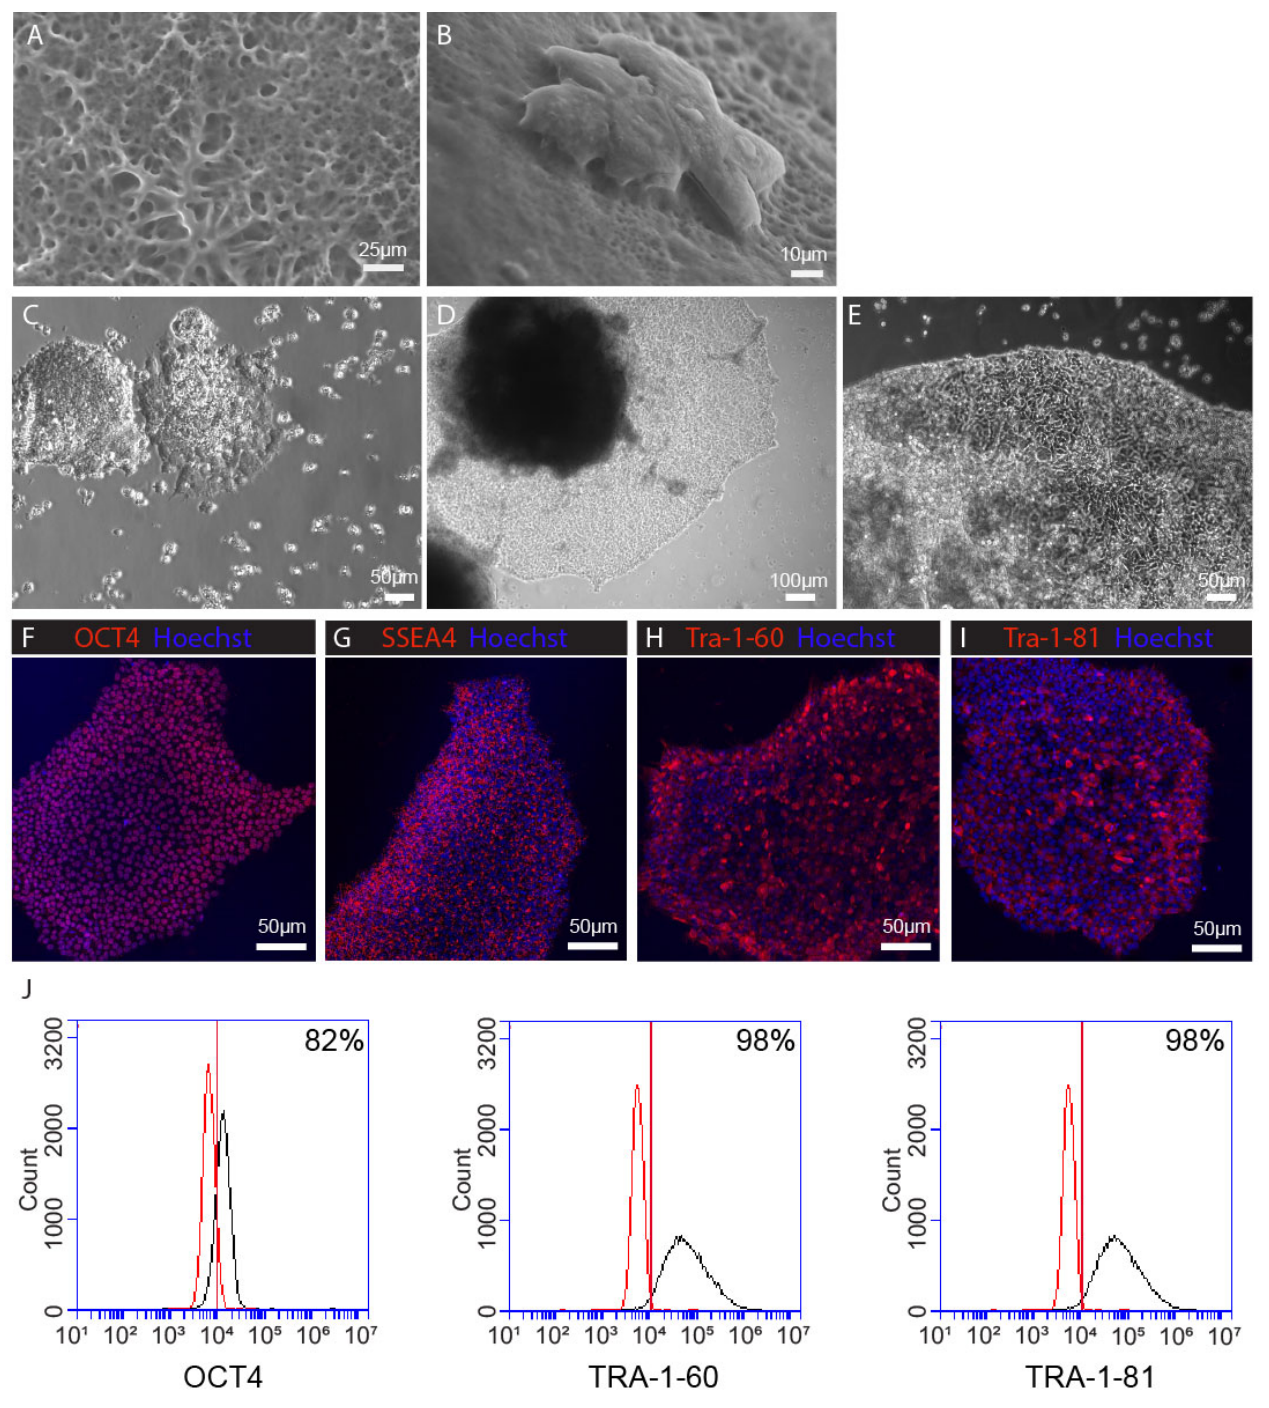
Figure 2. Attachment of human iPSC colonies and formation of neural derivatives on GelMA hydrogel. ( A ): SEM showing surface porosity of 5% GelMA. ( B ): SEM showing attachment of iPSCs on surface of GelMA. ( C – E ): Bright-field microscopy images showing flattened morphology of iPSC colonies at day 4 expansion, characteristic flattened morphology of an iPSC colony after day 21 expansion, and characteristic cuboidal and high nuclear-cytoplasmic ratio morphology of iPSCs seen at higher magnification, respectively. ( F – I ): Immunophenotyping of iPSCs at day 21 expansion showing expression of pluripotency markers: OCT4, SSEA4, TRA-1-60, and TRA-1-81, respectively. ( J ): Flow cytometry of iPSCs confirming expression of OCT4, TRA-1-60, and TRA-1-81. Red histograms indicate the isotype